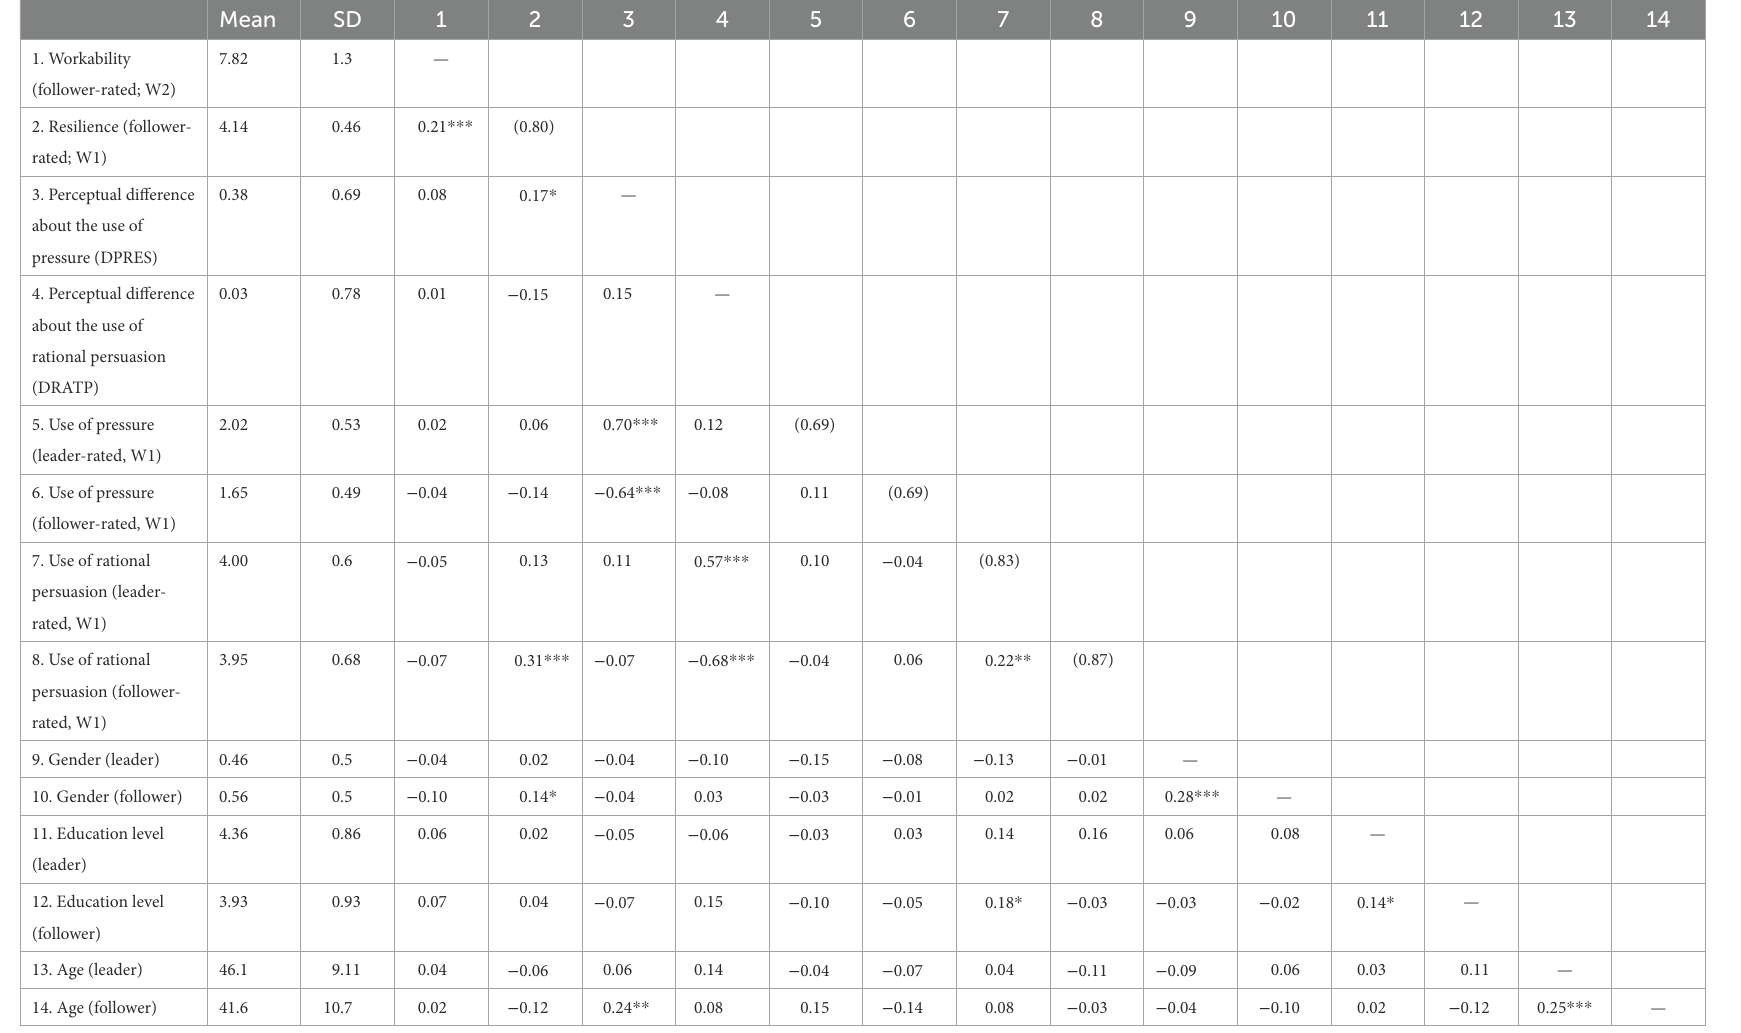
TABLE 1 Correlation